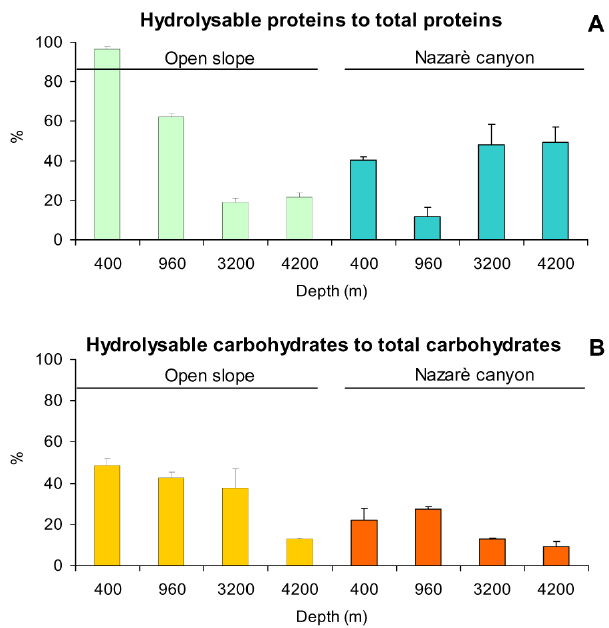
Fig. 6. Spatial patterns of the contribution of (A) enzymatically hy- drolysable proteins and (B) carbohydrates to their respective total pools in surface sediments of the Nazar`e canyon and adjacent open slope of the Portuguese margin. Standard deviations are reported.